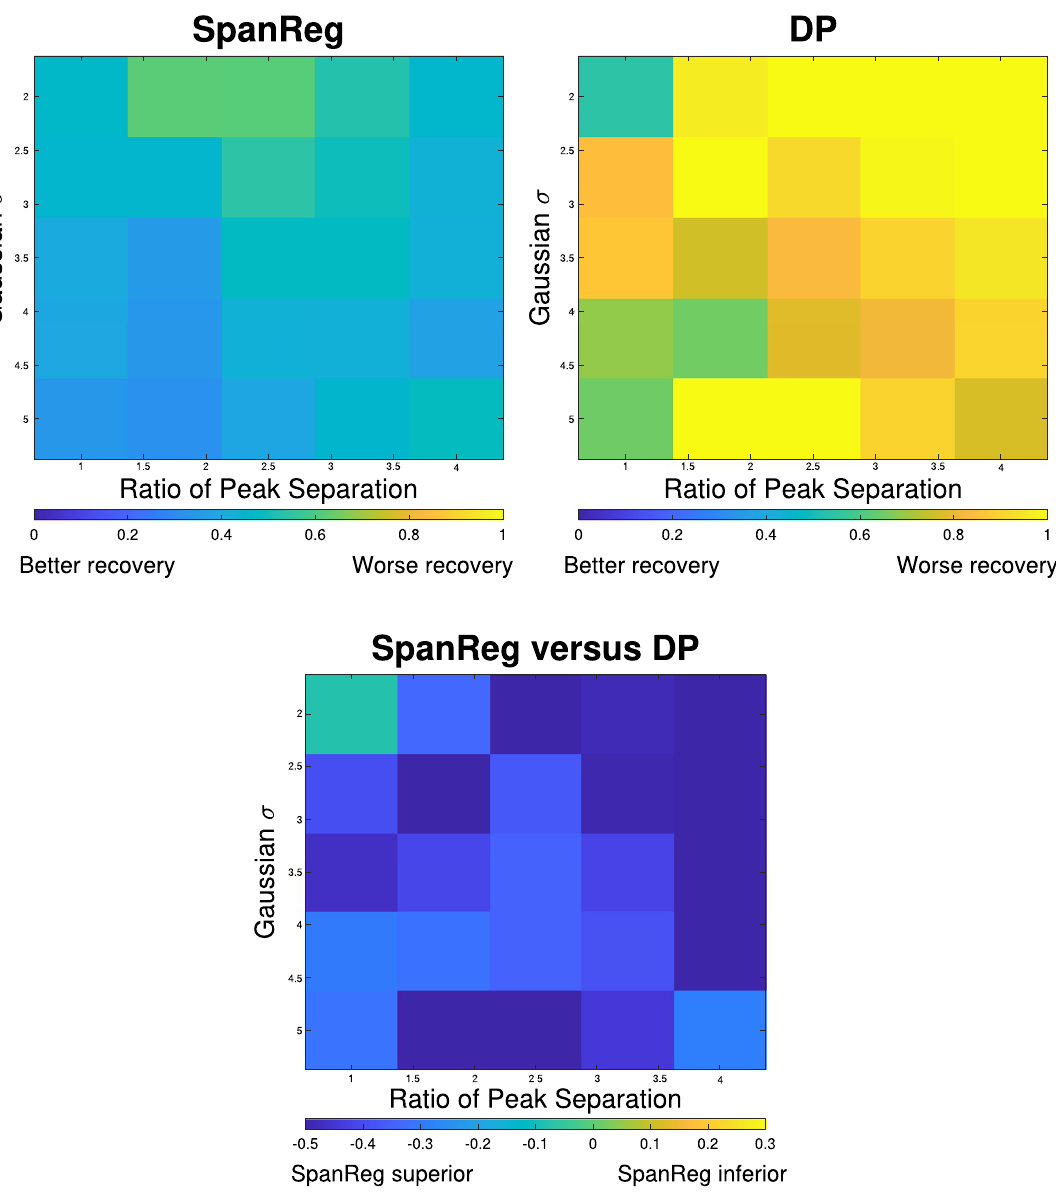
Figure 2. Heat maps showing relative errors for SpanReg (upper-left), discrepancy principle (upper-right), and their differences ε diff (bottom), as defined in the